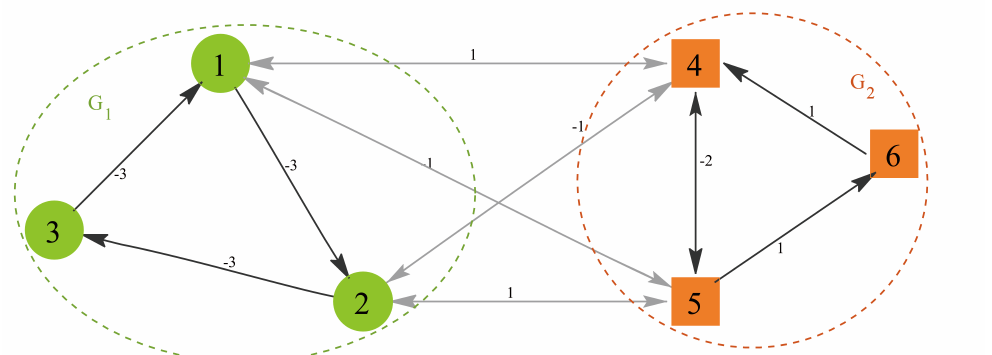
Figure 9. Example 2 of the balanced couple topology for two